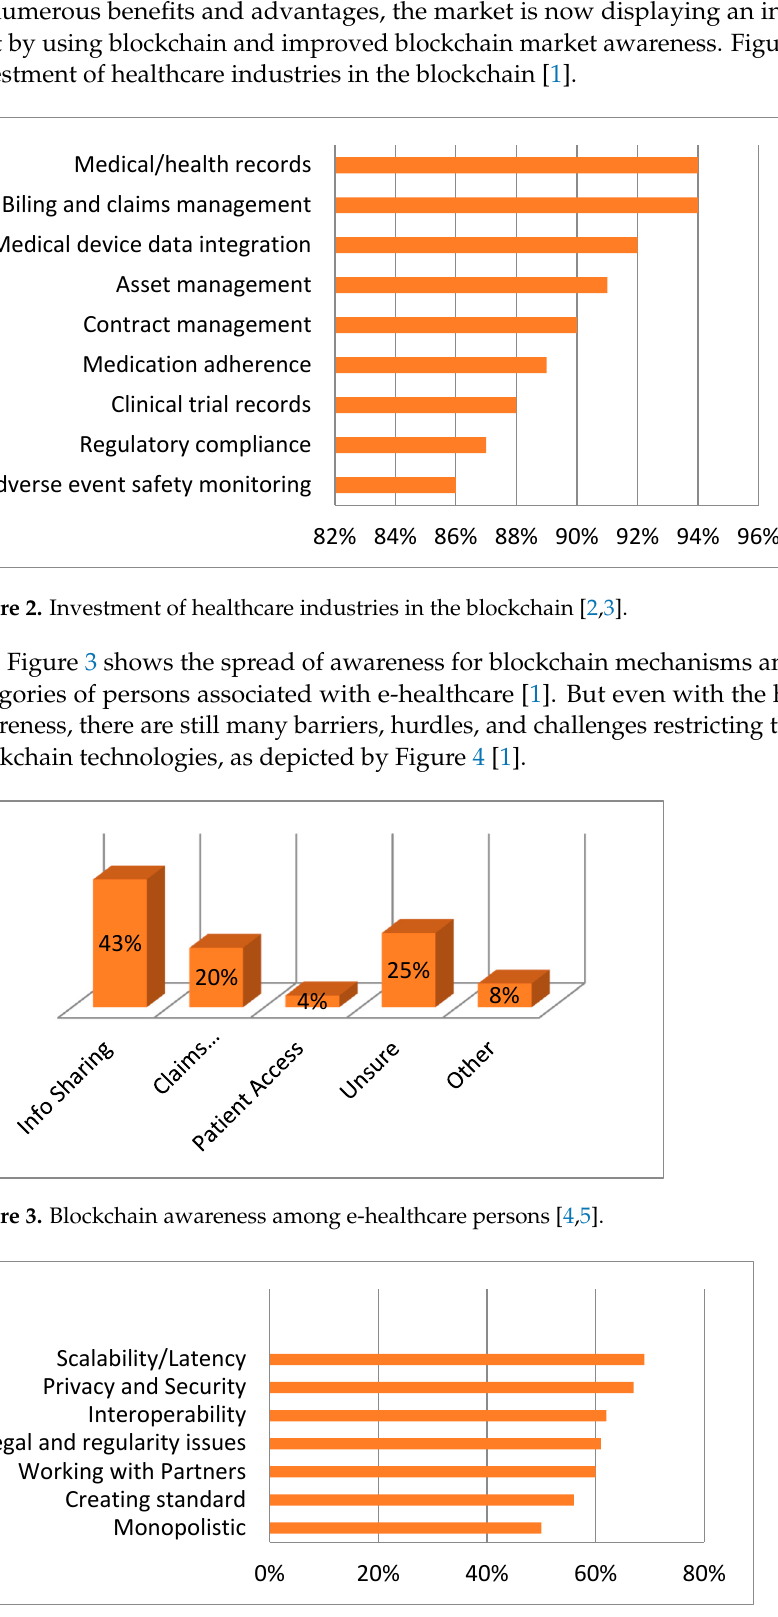
Figure 4. Challenges and barriers in the adoption of blockchain technology [6–8].